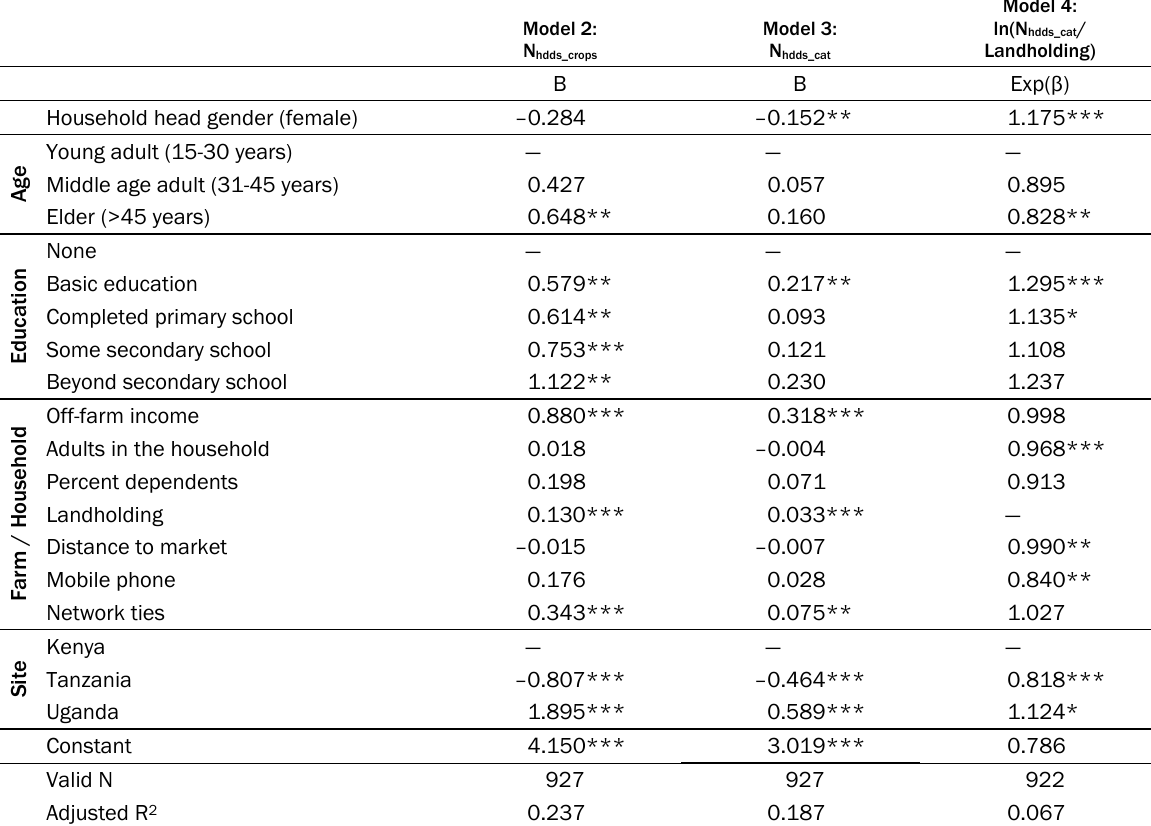
Table 7. Correlates of the Number of HDDS Food Crops (hdds_crops) and the Number of Different Food Groups (hdds_cat) Grown, Both Overall and Per Hectare of